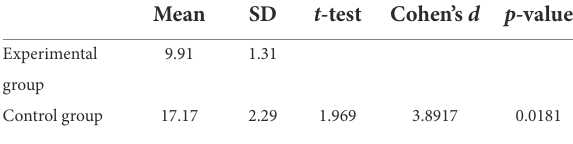
Table 4 Student’s t -test results for EG and CG’s post-test values of the modified K10 test.